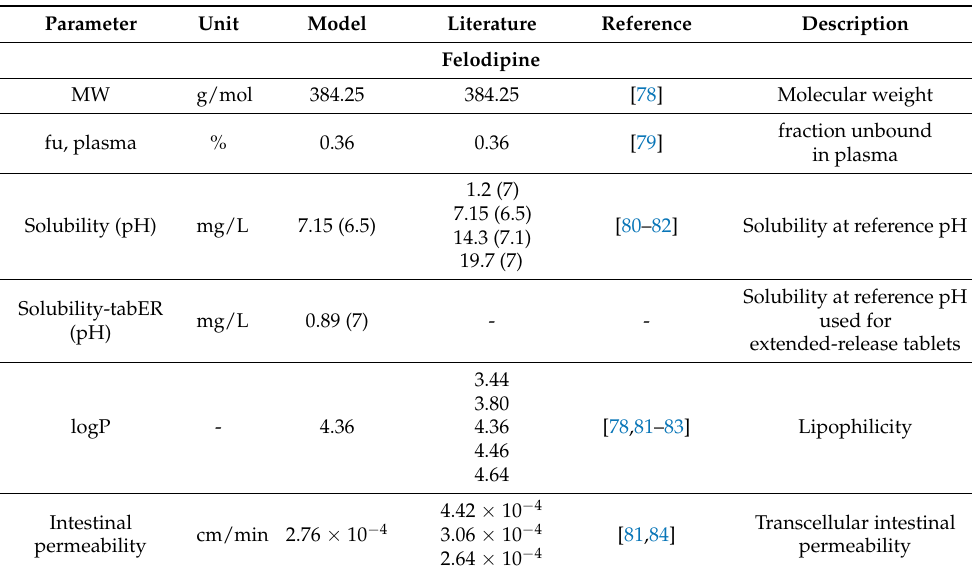
Table 2. Drug-dependent parameters of the felodipine PBPK